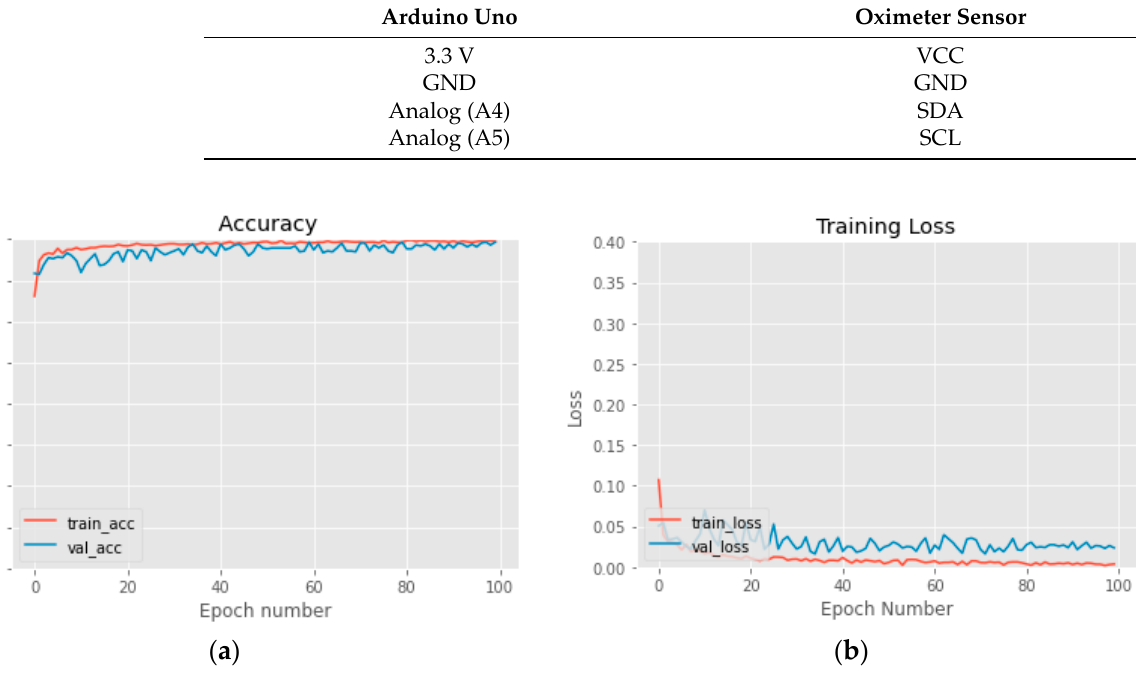
Figure A2. The Britz health band.